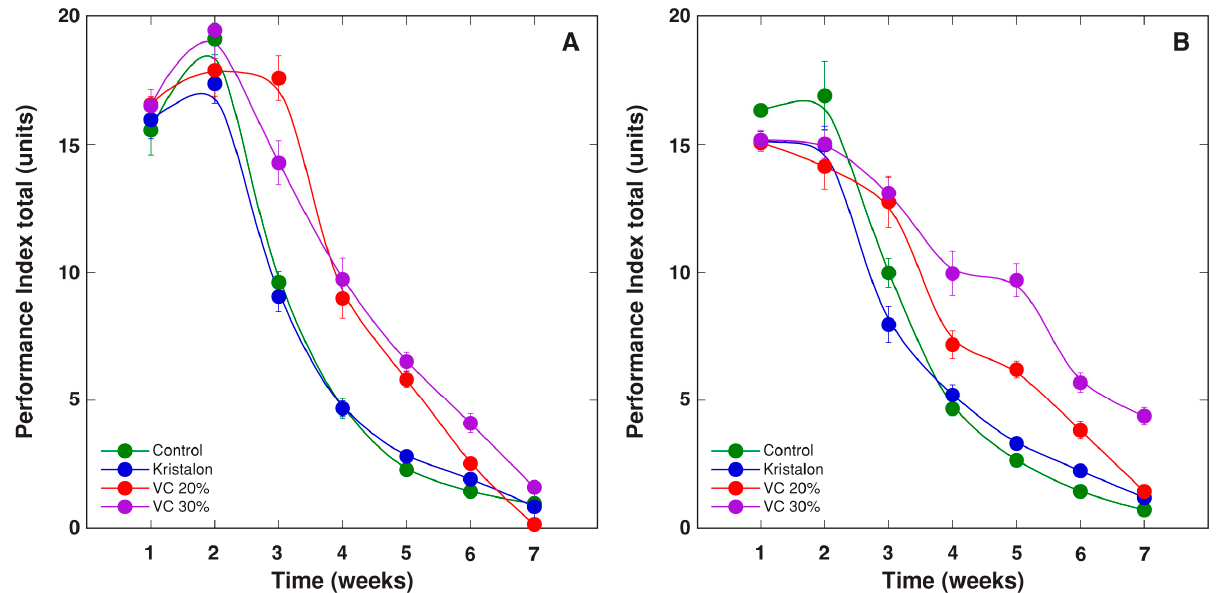
Figure 13. Changes of chlorophyll a fluorescence parameter P Itotal , as affected by mineral fertilizer (Kristalon) and amendment with vermicompost (VC) at a 20% and 30% ( v / v ) rate in Dracocephalum moldavica plants grown in peat substrate ( A ) or commercial garden soil ( B ). Results are means ± SE from five replicates for each treatment, three measurements per replicate.